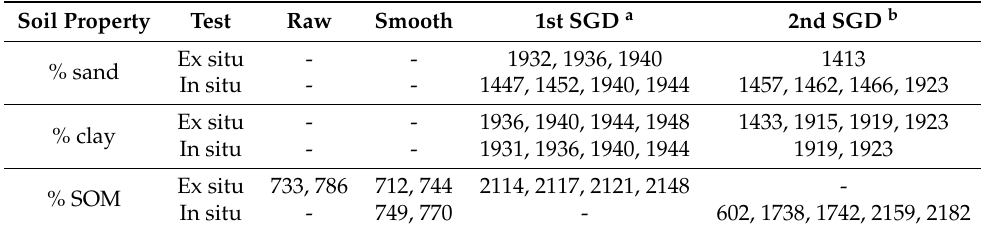
Table 3. vis–NIR wavelengths (nm) indicating the highest correlation (R 2 ) and ratio of spread over error (RSE) and with % sand, % clay and SOM